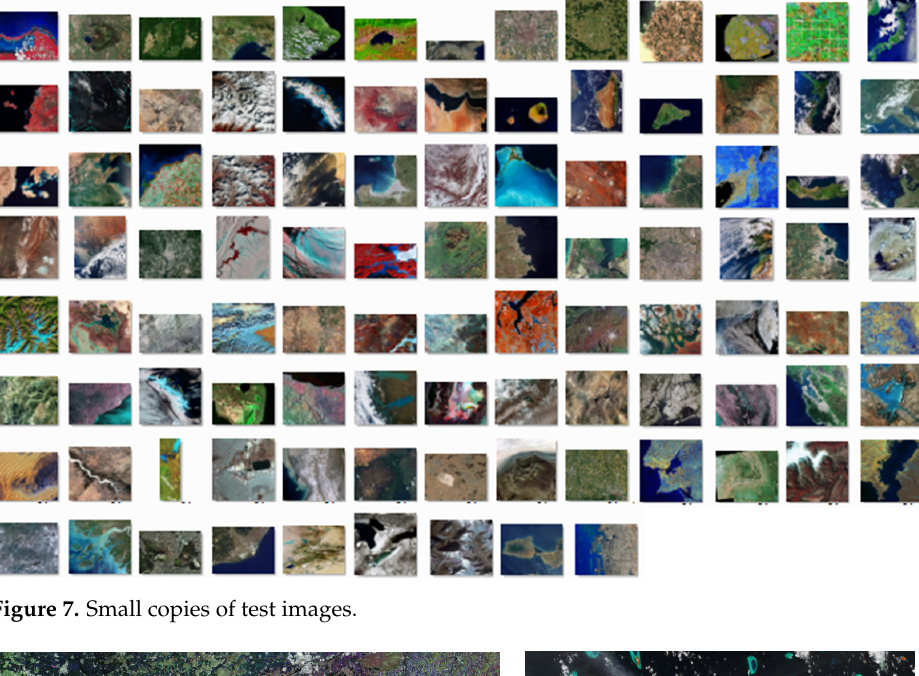
Figure 7. Small copies of test images.